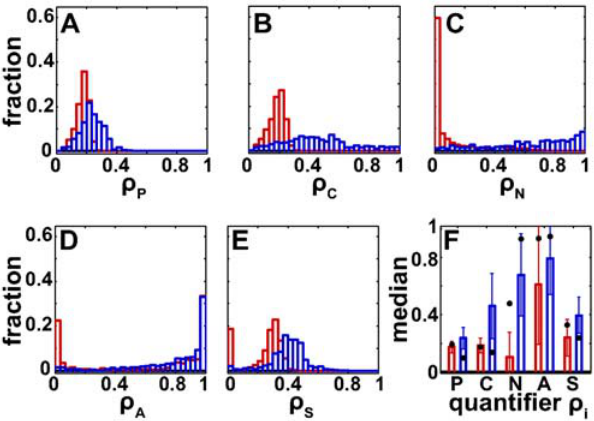
Figure 4. The two-sites model (blue) has greater local robustness than the autocatalytic model (red). Shown are the distributions of (A) robustness to local parameter perturbations r P , (B) robustness to total concentration perturbations r C , (C) robustness to molecular noise r N , (D) attraction of the cycle r A , and (E) sensitivity of the period r S . In (F) median values are shown with their associated standard deviation (error bars) for both models and all five quantifiers. Black dots indicate local robustness values for the previously published parameter vector’s [31,32].